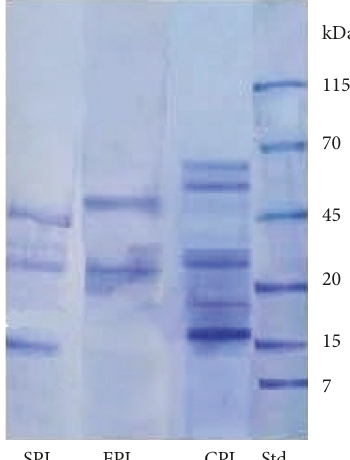
Figure 2: Electropherogram of oilseed protein isolates. Sesame protein isolates (SPI), flaxseed protein isolates (FPI), canola protein isolates (CPI), and standard (Std) are